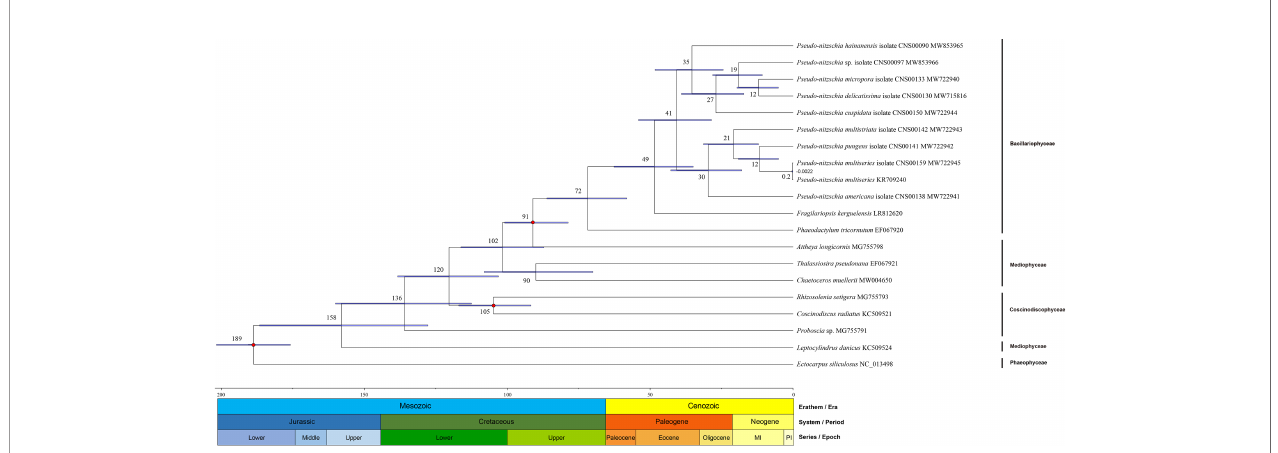
FIGURE 7 | Divergence time of 18 Bacillariophyta species (including 10 Pseudo-nitzschia strains) and one Ochrophyta species. Node values of the tree represent the average and gray bars of every node represent 95% credible interval of divergence time. The values under nodes are the divergence time and range of variation. Color blocks under the tree represent geological